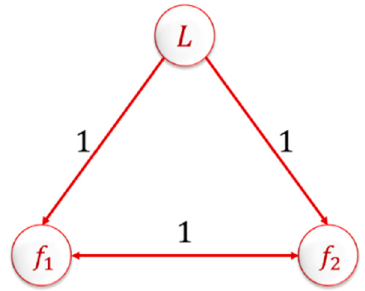
Figure 6. The overall ith quadrotor system with the consensus controller.